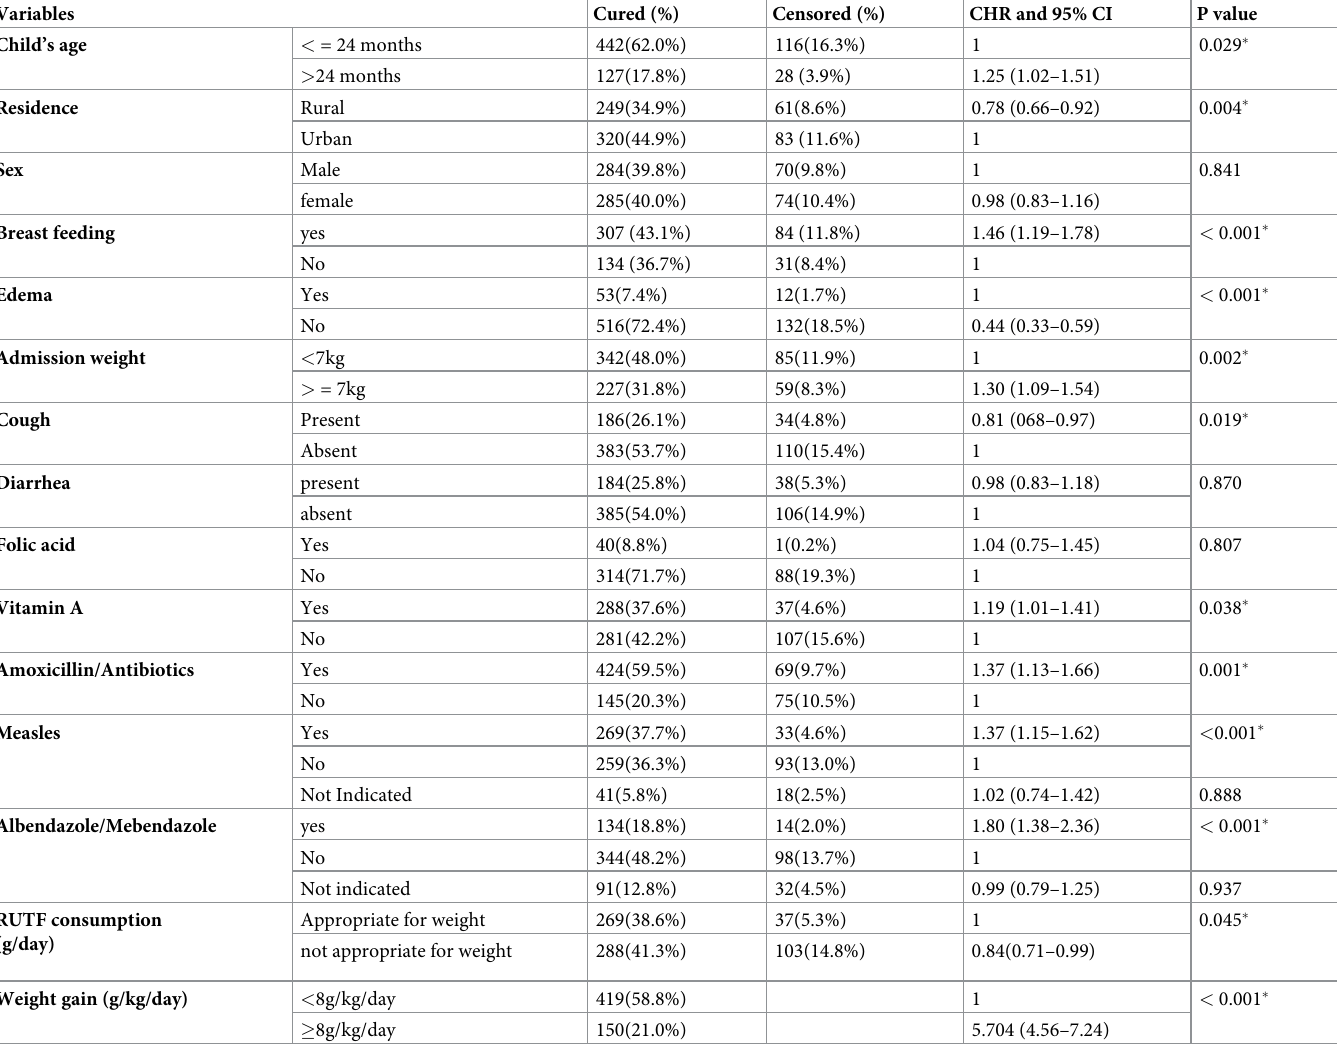
Table 6. Bivariate Cox-regression for prediction of time to recovery from SAM under OTP in Dire Dawa, Ethiopia; from January, 2013 to December, 2016.